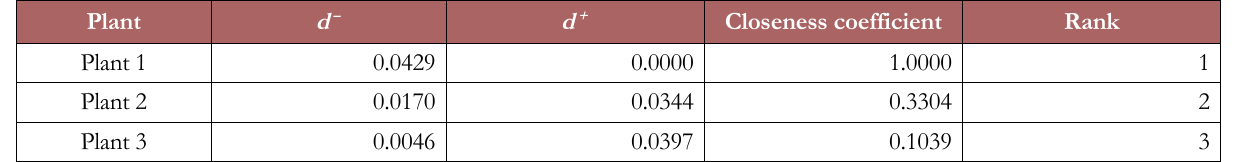
Table 4. Distance, closeness coefficient and the rank of each plant (AM)